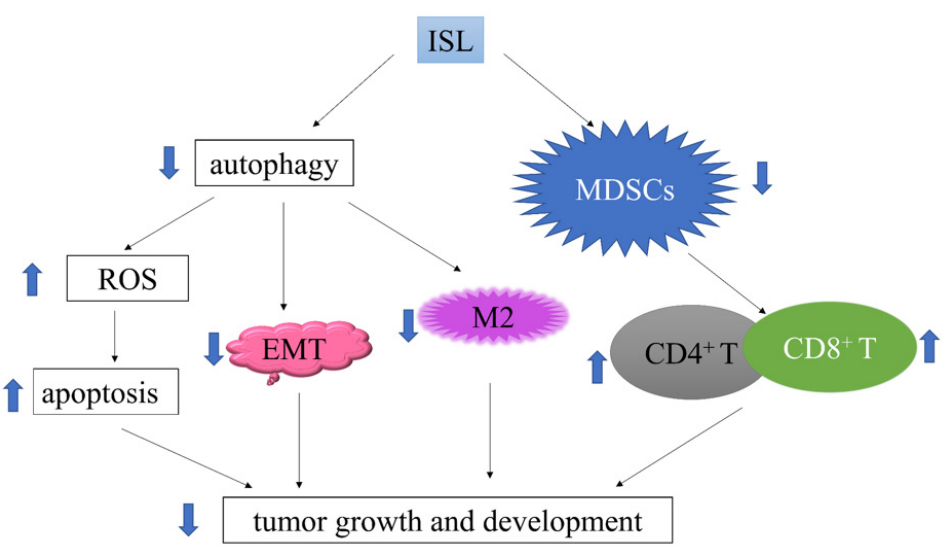
Figure 1. ISL inhibits pancreatic ductal adenocarcinoma cell growth by the blockade of autophagy and the regulation of the tumor microenvironment, leading to the increased activation of reactive oxygen species and the promotion of apoptosis together with the immunomodulation of tumor im-